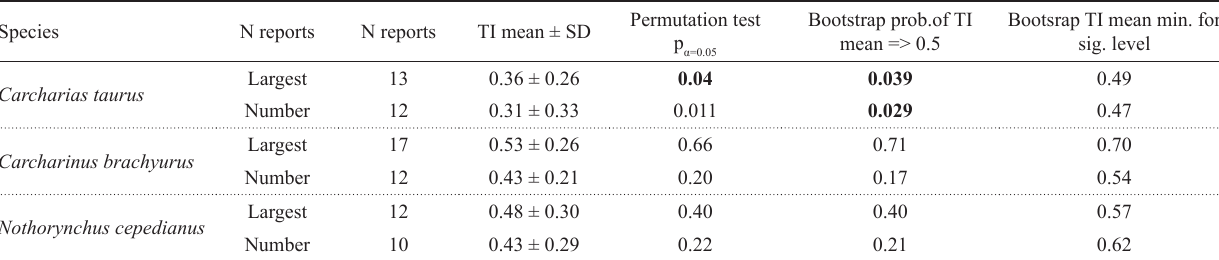
Table 2. Time Index (TI) for the best day´s catch records of the largest animal ever caught and the maximum number of individuals for each species. Number of reports for each species and TI (N reports), TI mean and standard deviation (TI mean ± SD), permutation test level of significance (Permutation test pα=0.05), bootstrap probability of a TI mean => to 0.5 (Bootstrap prob. of TI mean => 0.5) and bootstrap TI mean minimum of significant magnitude. In bold are noted a significant level of